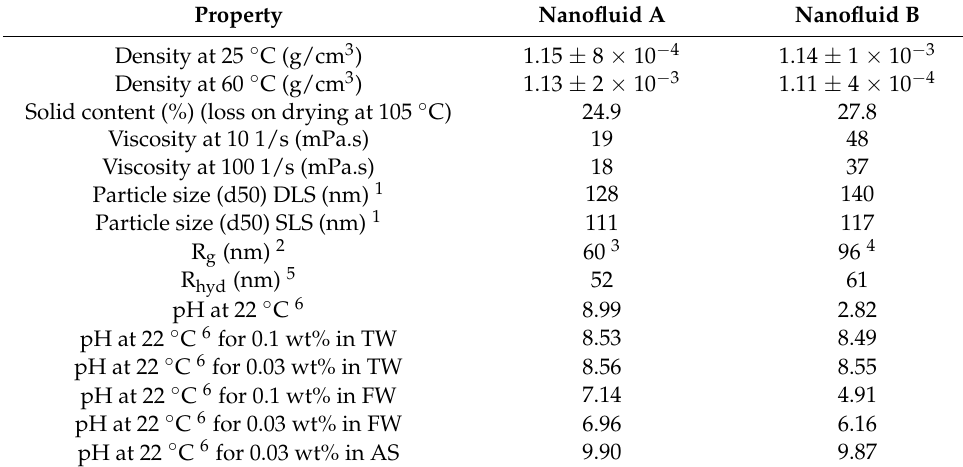
Figure 2. Zeta ( ζ ) potential and specific conductivity for the materials used in this work. Measurement was performed using deionised water as dispersion media with HCL as acid and KOH as base. Nanofluid A is shown in ( a ) and Nanofluid B in ( b ). The particles are moved relative to their diffuse electrical double layer (EDL) to form fluctuating dipoles. An alternating current, i.e., the colloidal vibration current, is generated, which subsequently allows the calculation of Zeta potential. NF B is more negatively charged due to the polar functionality of its surface coating. This should result in better colloidal stability. One could argue that no marked variation can be considered as a function of pH since the Zeta potential appears almost constant (measured error +/ − 5 mV). Table 3. Properties of Nanofluids (NF) used in this